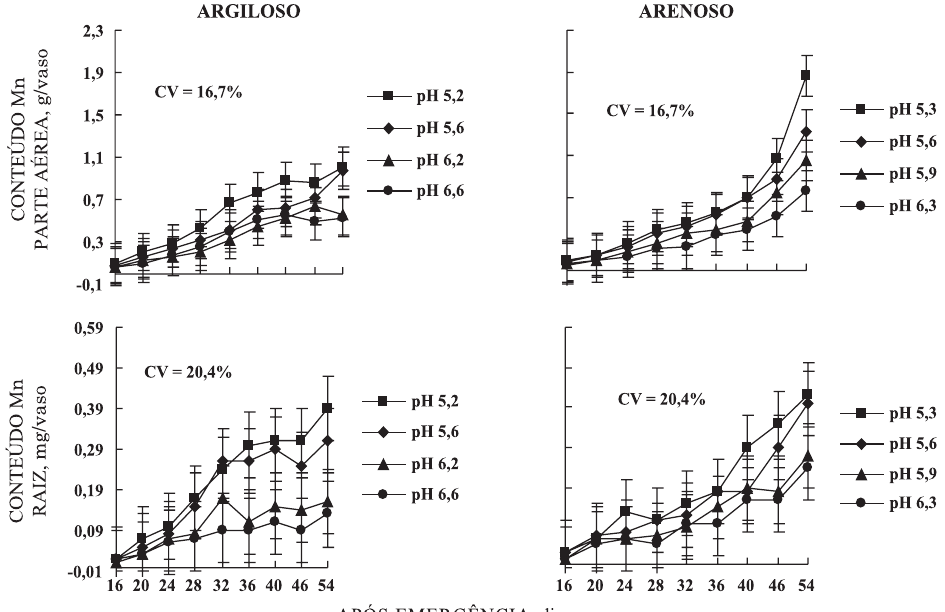
Figura 7. Conteúdo de manganês na matéria seca da parte aérea e do sistema radicular de plantas de soja, em diferentes épocas de avaliação após a emergência, em relação ao pH inicial do solo argiloso e do arenoso.